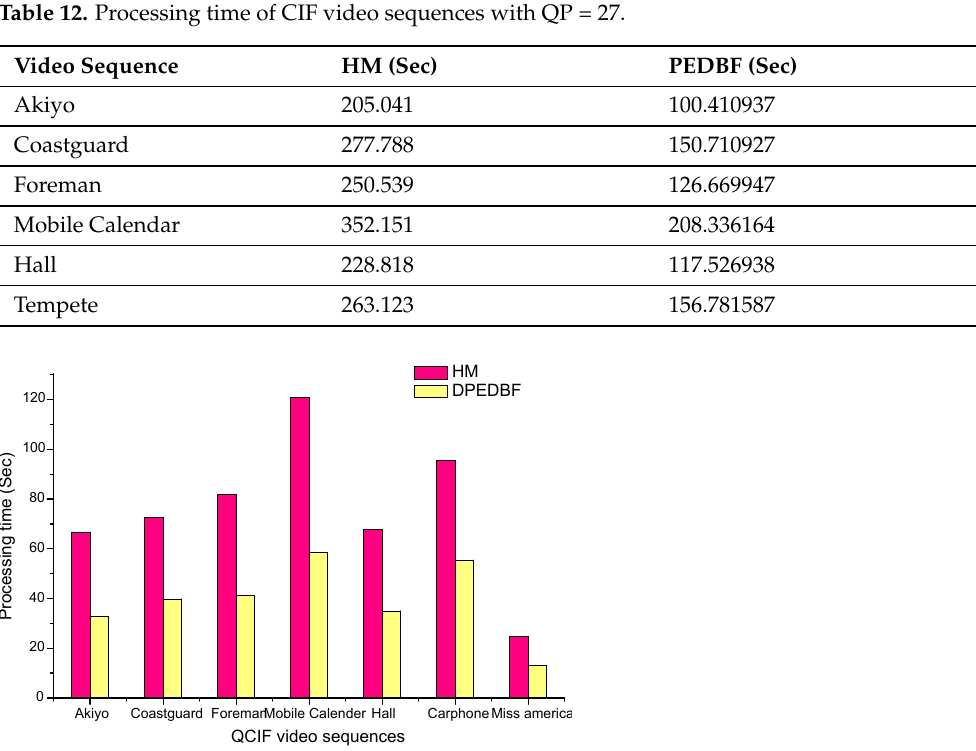
Figure 27. Comparison of processing time with HM for QCIF video sequences using QP = 27.